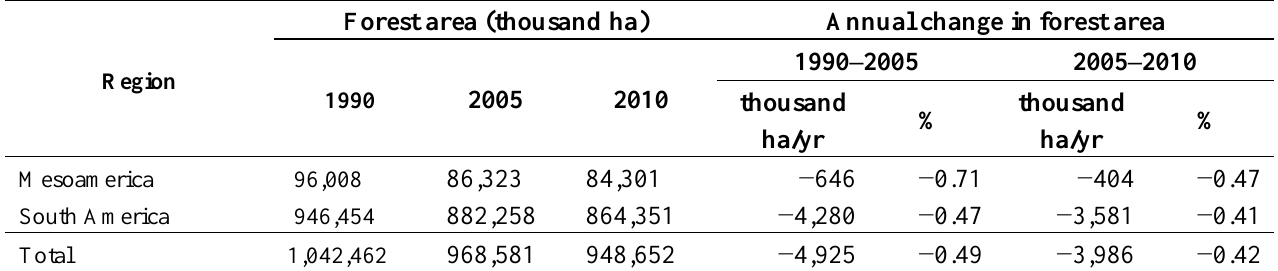
Table 4. Forest cover change in Latin America in selected